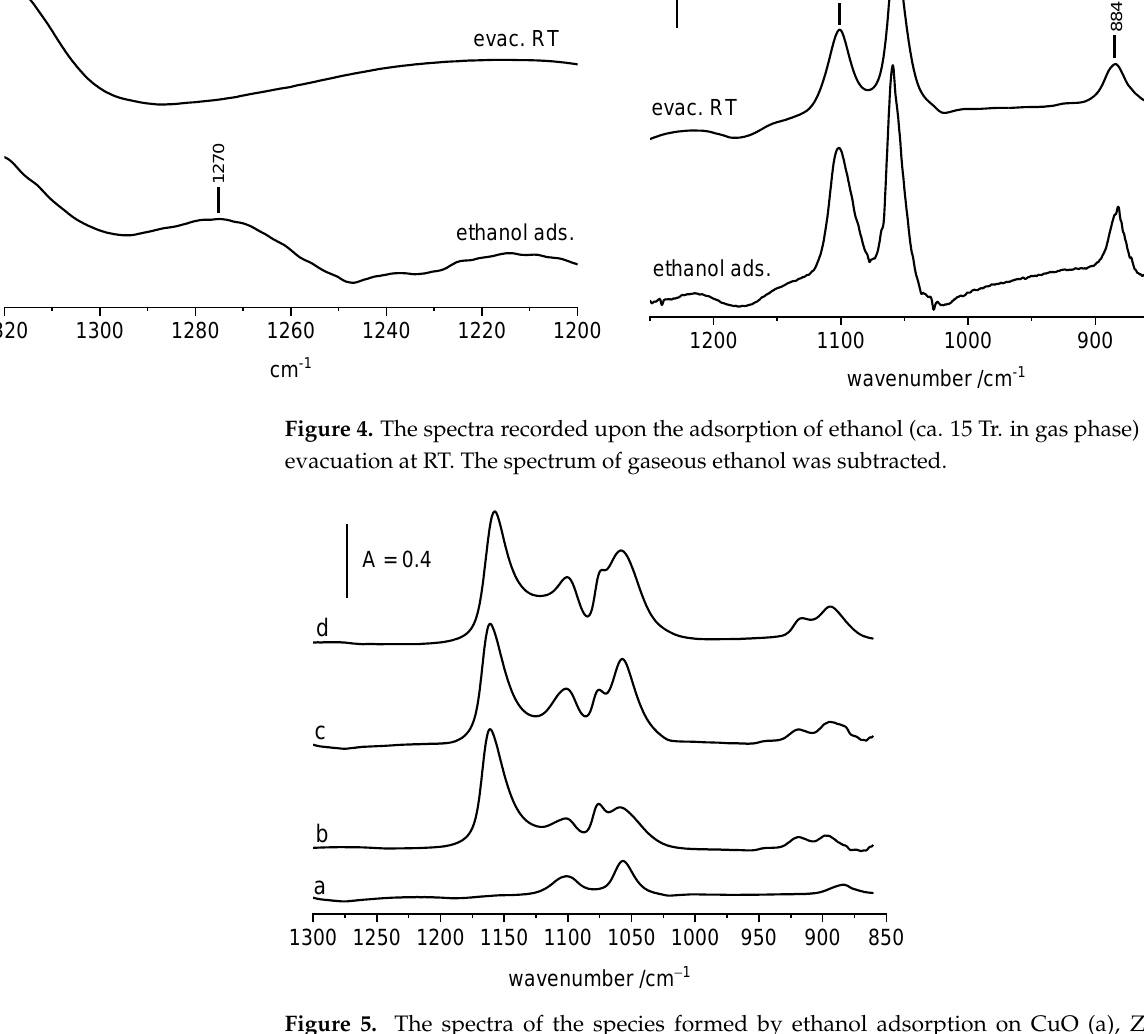
Figure 5. The spectra of the species formed by ethanol adsorption on CuO (a), ZrO 2 (b) and CuO/ZrO 2 (c) as well as the result of the addition of spectra a and b.